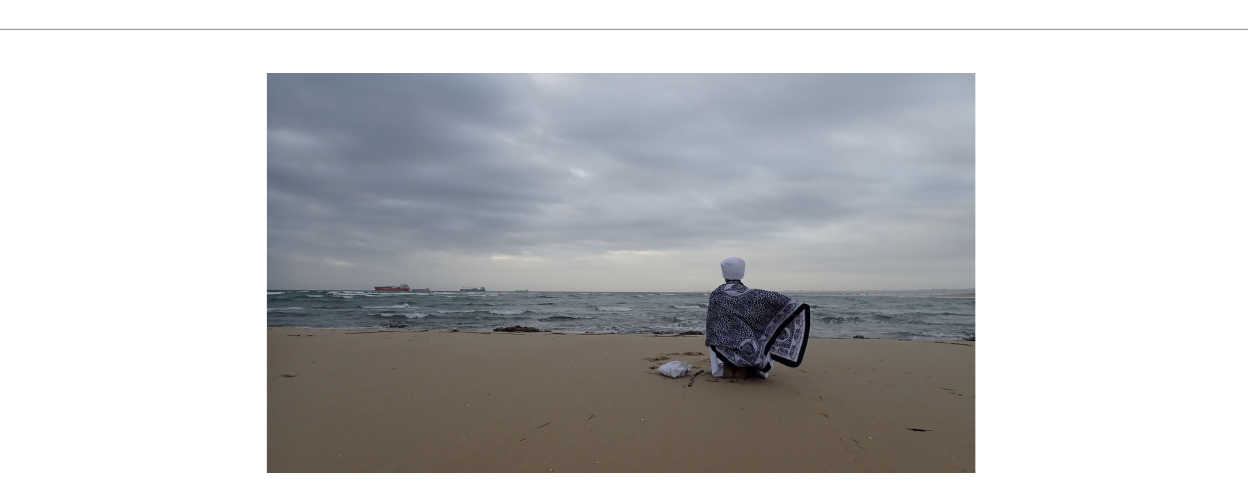
FIGURE 5 | Siyasanga Ntabeni, a sangoma (traditional healer), on a beach in Algoa Bay. The coastline of Algoa Bay is a place where Nguni traditional healers, Sangomas, come to connect and communicate with the